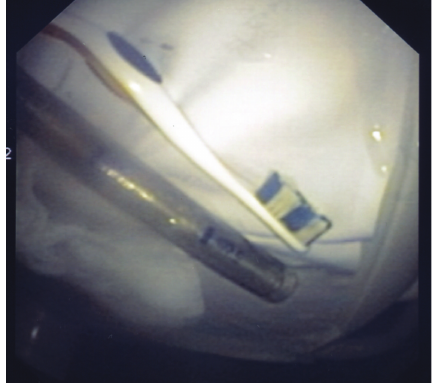
Figure 3: Extracted toothbrush and endoscopic